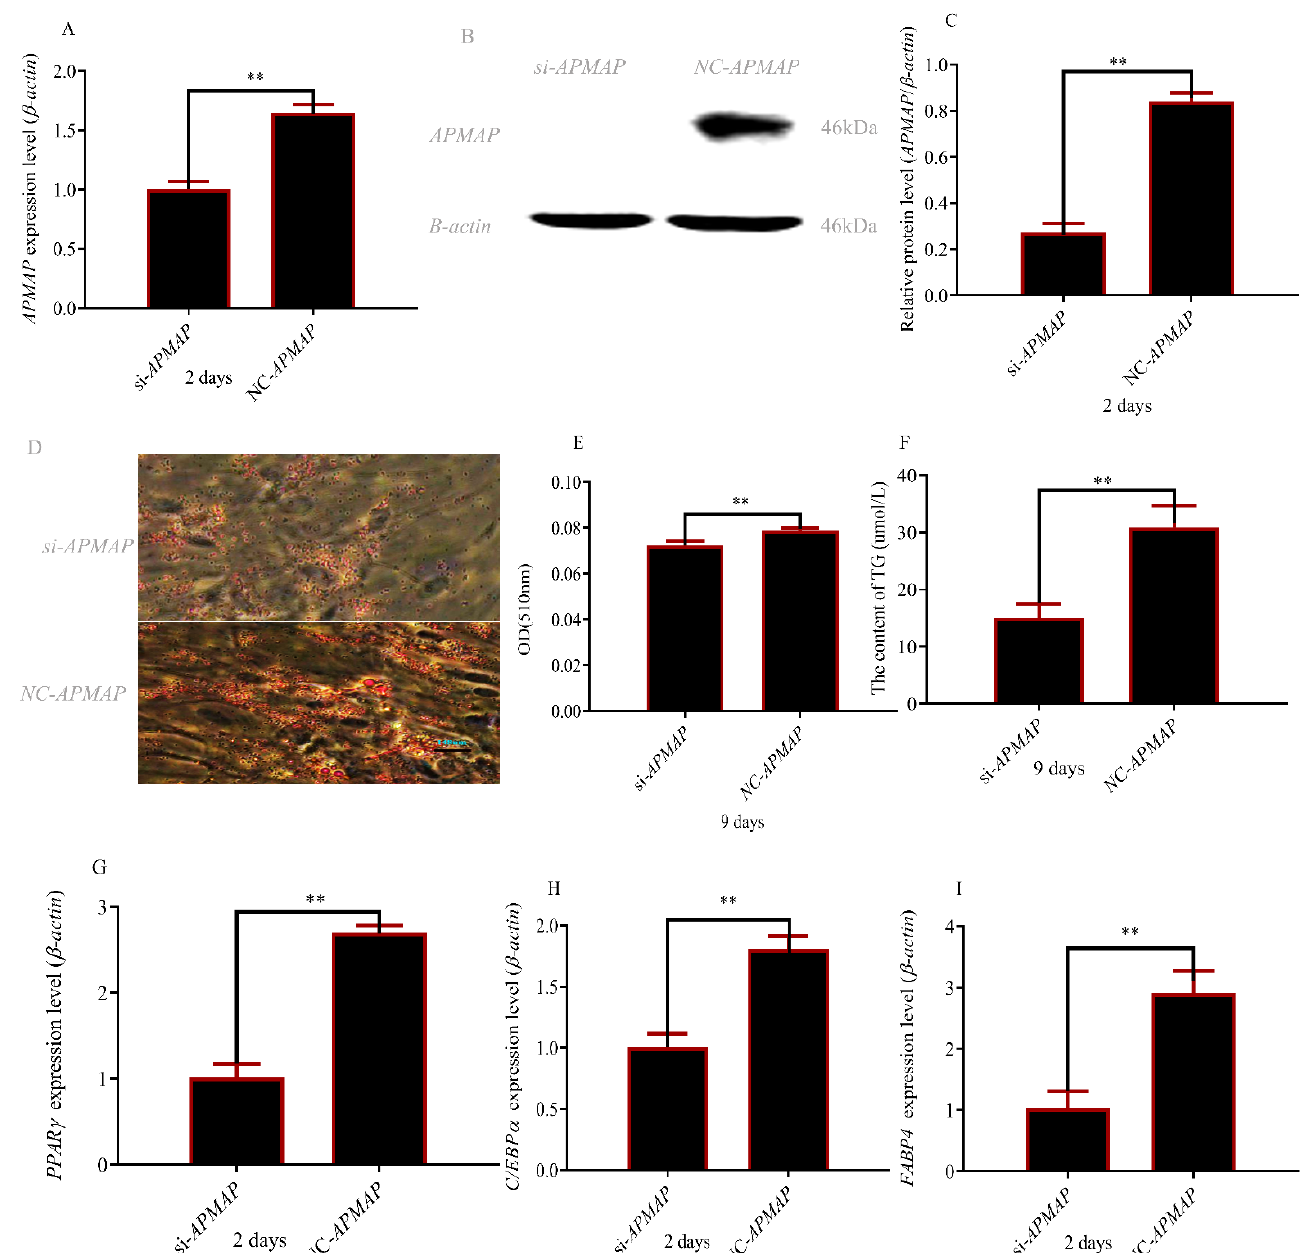
Figure 6. Inhibition of APMAP gene inhibited rabbit preadipocyte differentiation: ( A ) APMAP expression level after transfecting with si-APMAP and NC; ( B,C ) APMAP protein level after transfecting with si-APMAP and NC; ( D ) size of lipid droplets (magnifications = 10 × 10); ( E ) content of lipid droplets; ( F ) Triglyceride content; ( G – I ) PPARγ , CEBPα , and FABP4 expression after transfecting si- APMAP and NC ( ** p ≤ 0.01